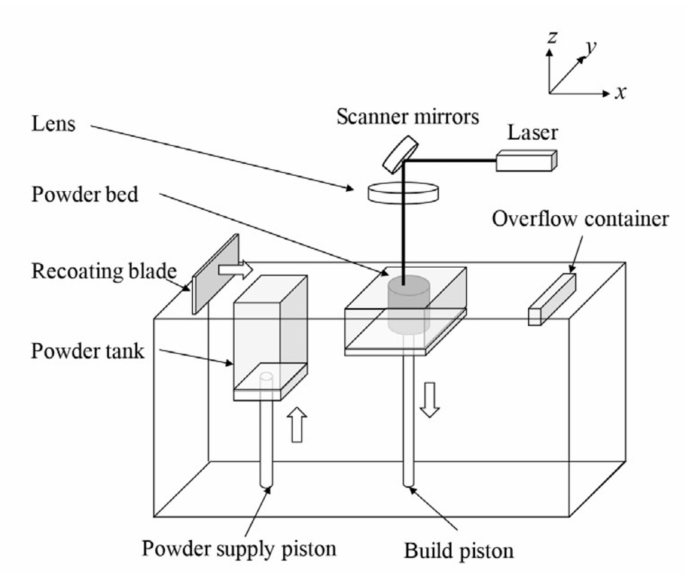
Figure 5. Schematic of powder bed fusion equipment [34]; with permission from Elsevier.